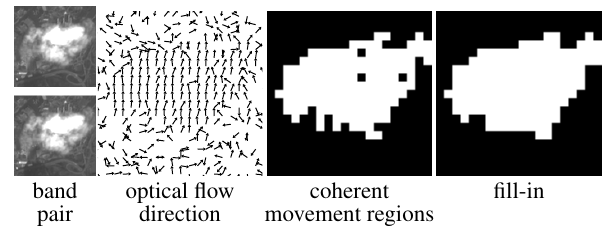
Figure 2. Steps of the proposed